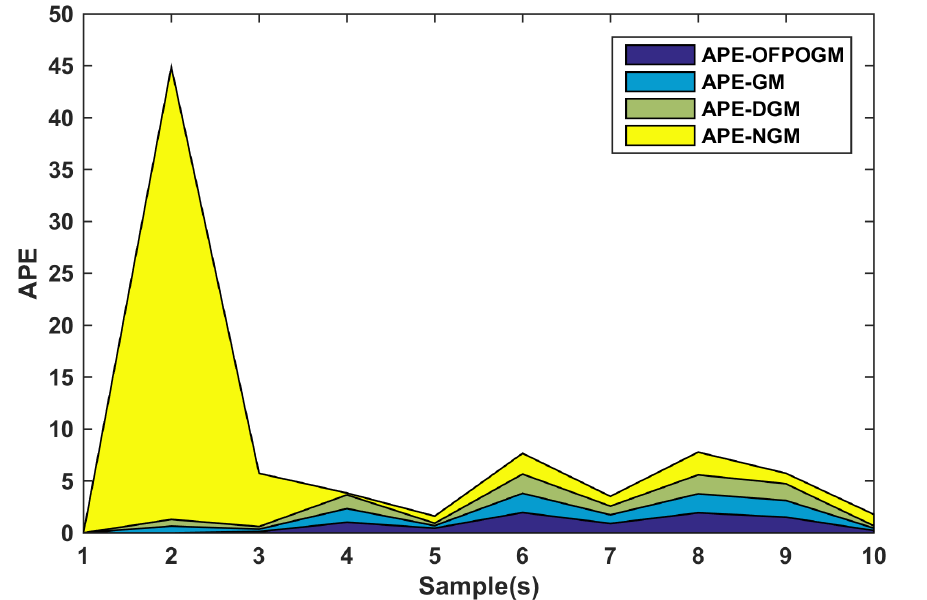
Figure 1. APE—power generation